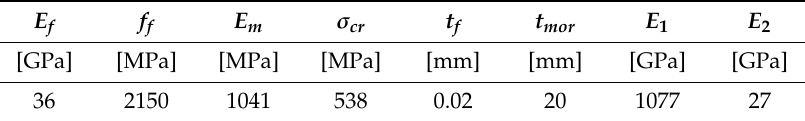
Table 2. Dimensional parameters for the analyses.